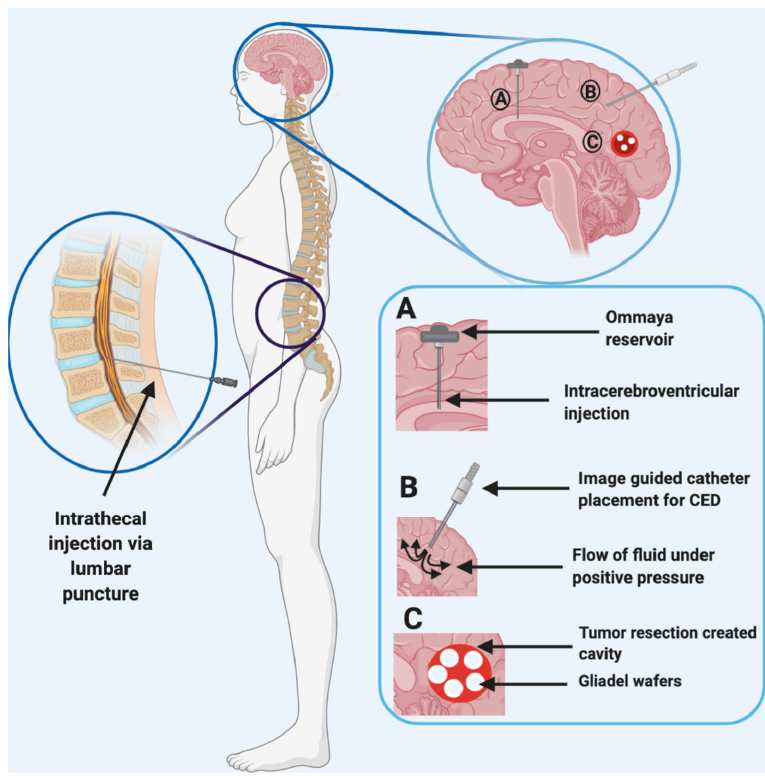
Figure 3. Various invasive technologies to increase drug delivery to the brain by bypassing the BBB/NVU include intrathecal injection via a lumbar puncture and various intracranial techniques. These include ( A ) intracerebroventricular injection using the Ommaya reservoir, ( B ) convection- enhanced delivery (CED) by way of intracerebral catheter placement, and ( C ) placement of